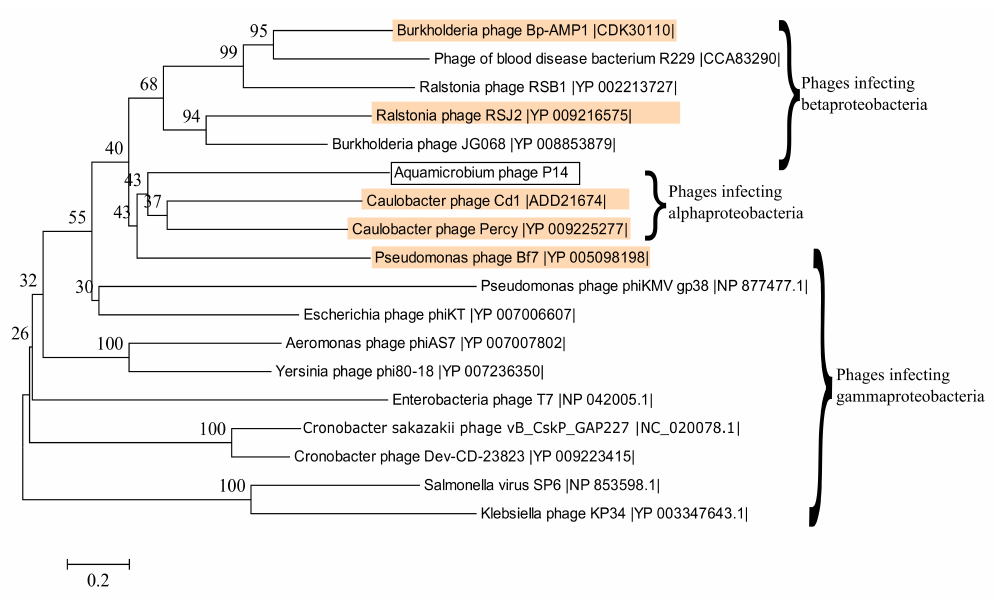
Figure 4. Phylogenetic tree constructed based on the DNA sequences encoding the tail fiber proteins of several phages. Phages that are also present in Table 2 are highlighted in orange. The best model for the phylogenetic tree construction was found by jmodeltest 2.1.10 [35] to be GTR+G+I. The model was then constructed using Mega6 [36] with 500 bootstrap